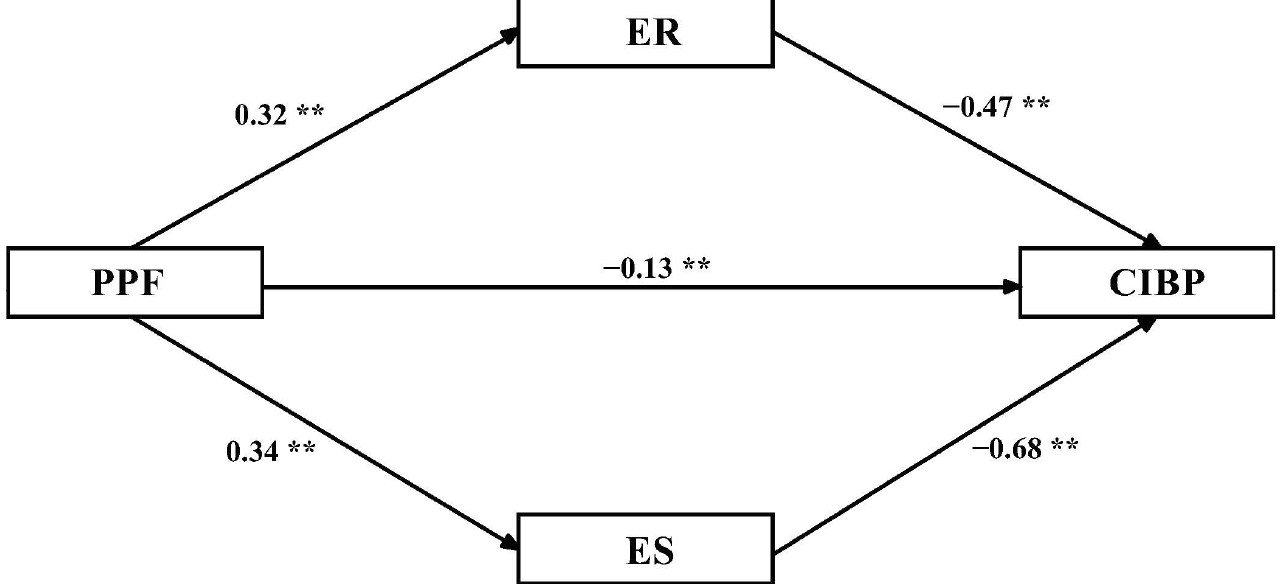
Figure 3. Model diagram of the effect of parental psychological flexibility on internalizing behavior problems. ** p < 0.01; PPF = parental psychological flexibility, ER = emotional regulation, ES = emotional stability, CIBP = children’s internalizing behavior problems.